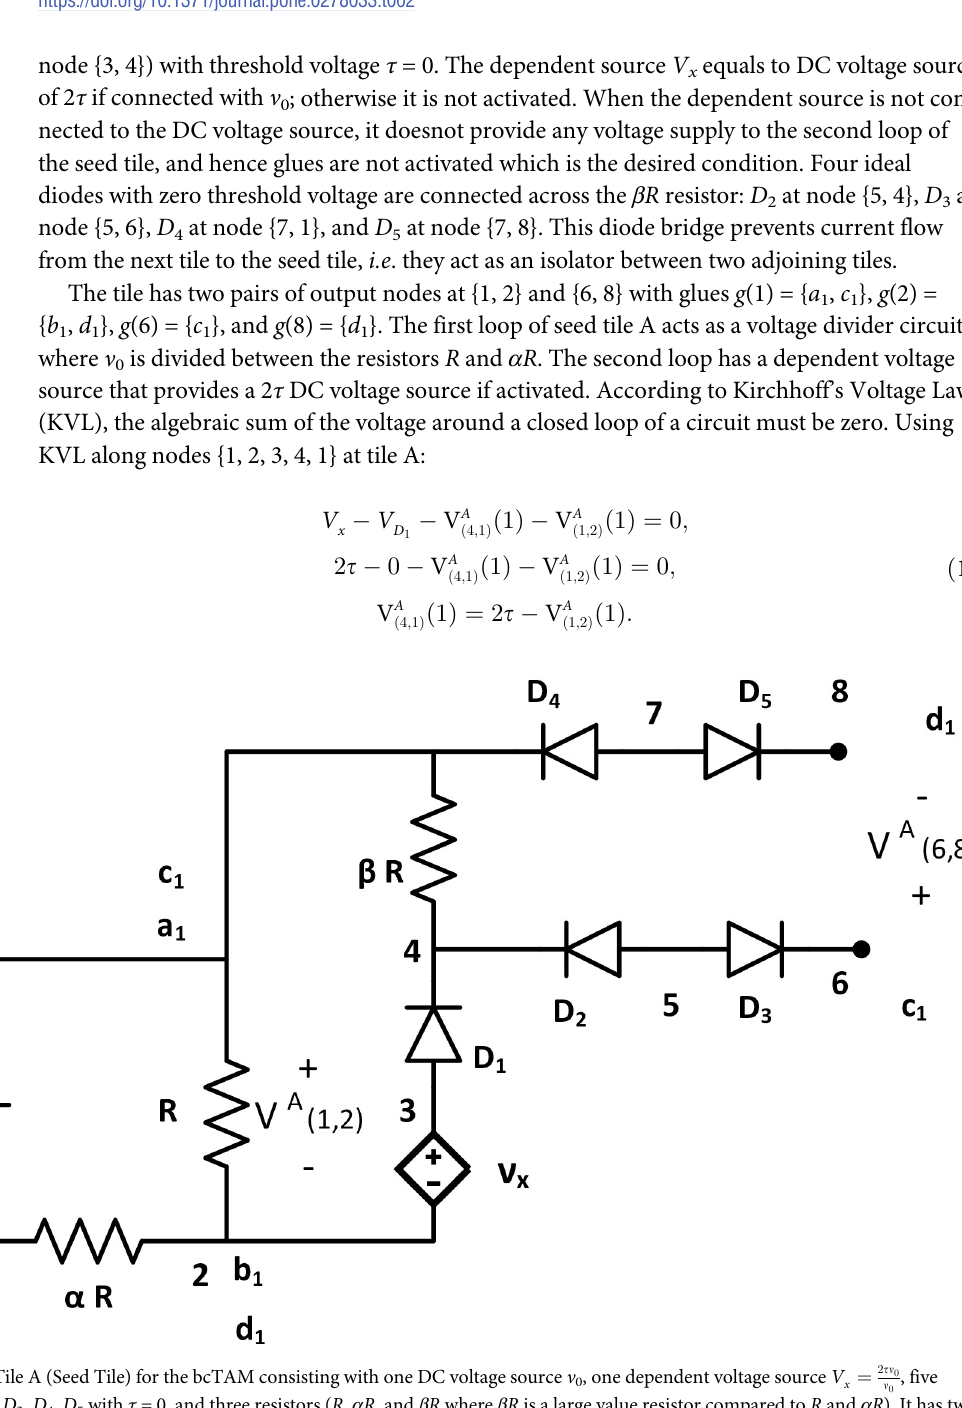
¼ 2 tn 0 , five x n 0